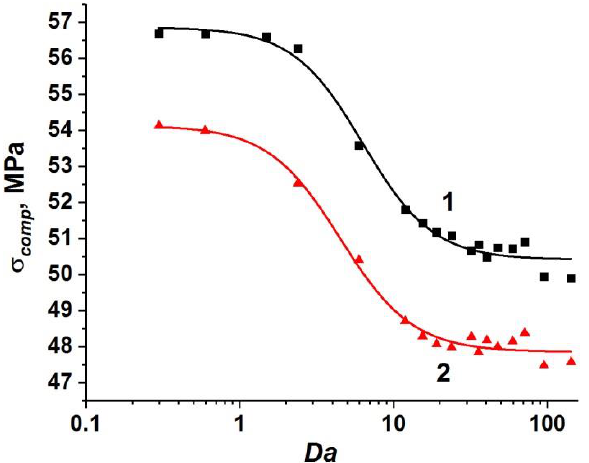
Figure 7. Examples of the dependence of compressive strength of water-saturated cement stone samples with different spatial arrangements of micropores (4 vol.%). Curves 1 and 2 correspond to the samples in Figure 6a,b, respectively.